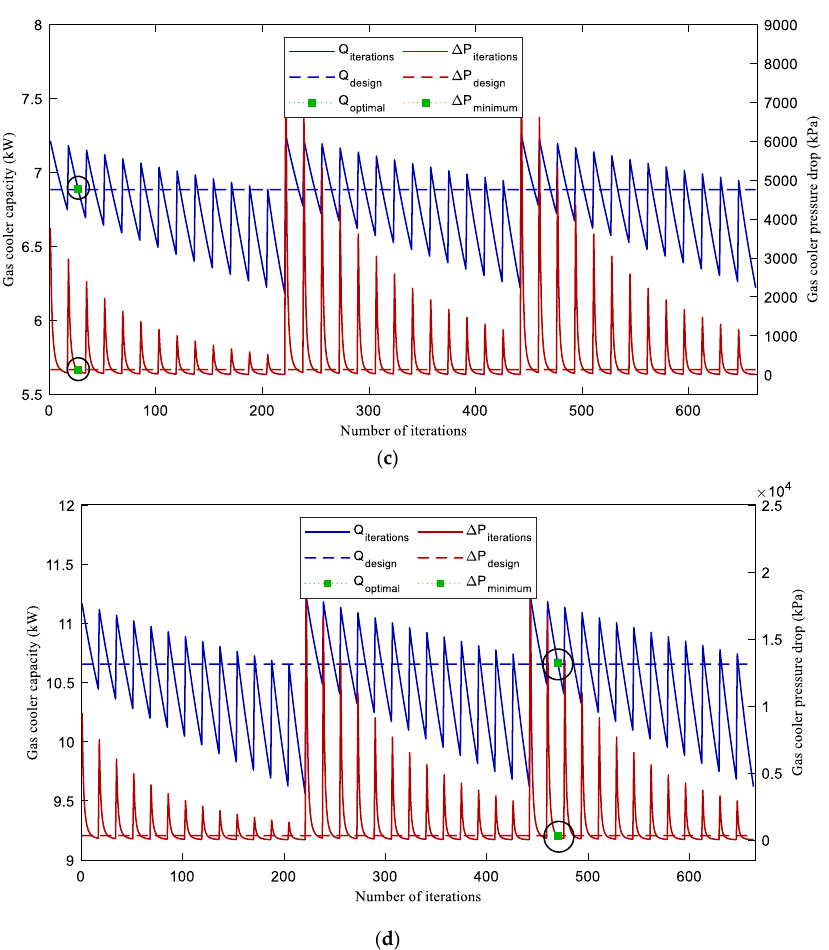
Figure 6. ( a ) Variation of gas cooler capacity and pressure drop with each iteration (I17-1); ( b ) variation of gas cooler capacity and pressure drop with each iteration (I6-6); ( c ) variation of gas cooler capacity and pressure drop with each iteration (M03-3); ( d ) variation of gas cooler capacity and pressure drop with each iteration (H03-5). The ΔP min at Q design for case I17-1 is predicted at iteration 470, shown in Figure 6a. When Q design = 3.34 kW at operating condition I17-1 with ΔP min , the number of tubes re- quired is 65, distributed in 5 passes containing 13 tubes each. The optimum number of ports for the ΔP min is 10, and the optimum length, width, and height for the Q design at the highlighted ΔP min are 0.290 m, 0.016 m, and 0.705 m, respectively. The optimal predicted ΔP min at condition I17-1 is about 41.68 kPa, which shows a pressure drop reduction of 15% in the optimal value compared with the design value. Similarly, for case I6-6, the ΔP min is predicted at iteration 249 for the given Q design , as shown in Figure 6b. This iteration’s geo- metric configuration exhibits the best pressure drop with the lowest value of 41.68 kPa, which shows an increase of 15% from the design to the optimal value. This corresponds